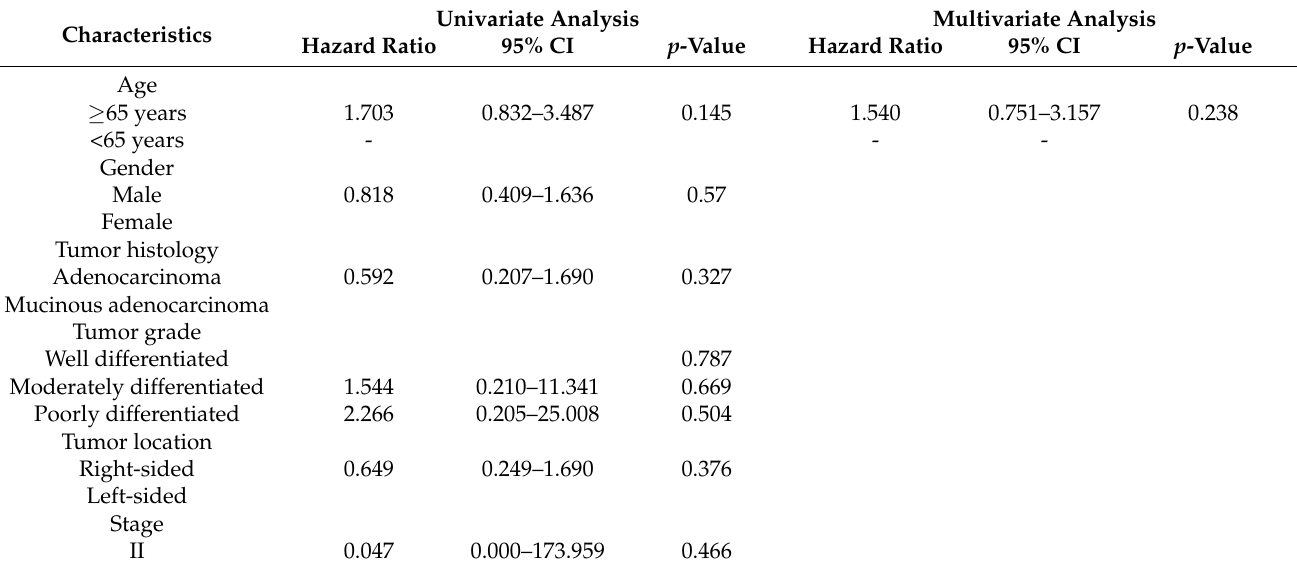
Table 3. Univariate and multivariate analysis for